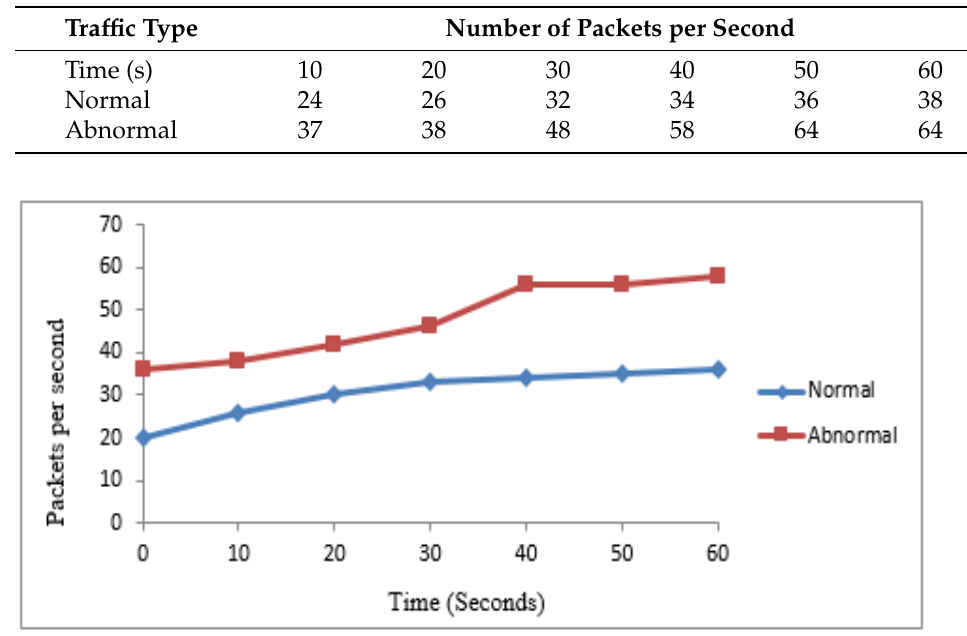
Figure 3. Experiment 1 for categorization of traffic.